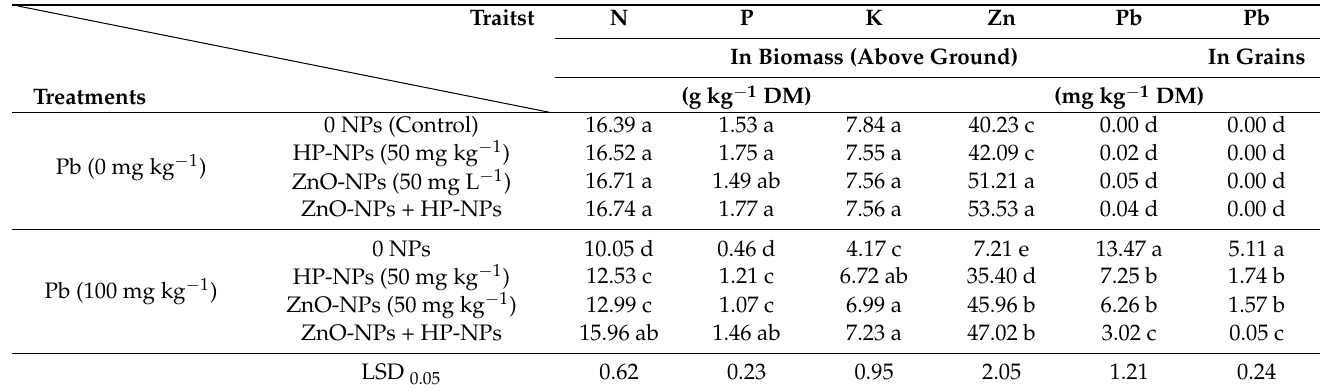
Table 5. Effects of nano-hydroxyapatite NPs (NH NPs), zinc oxide NPs (ZnO-NPs), and their combinations on nitrogen (N), phosphorus (P), potassium (K), zinc (Zn), and lead (Pb) in maize grown in soil contaminated with